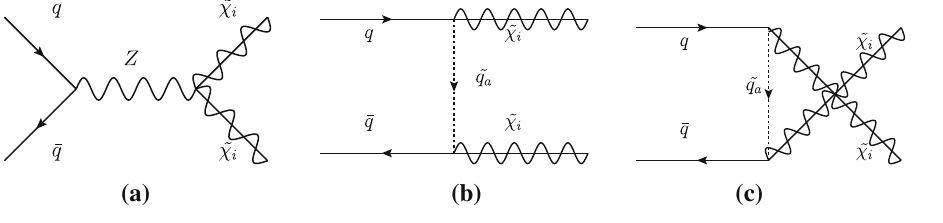
Fig. 3 Feynman diagrams for the production of a neutralino pair in the MSSM. Since the neutralino is a Majorana fermion, in addition to the s - ( a ) and t -channel ( b ) diagrams, a u -channel diagram ( c ) is also